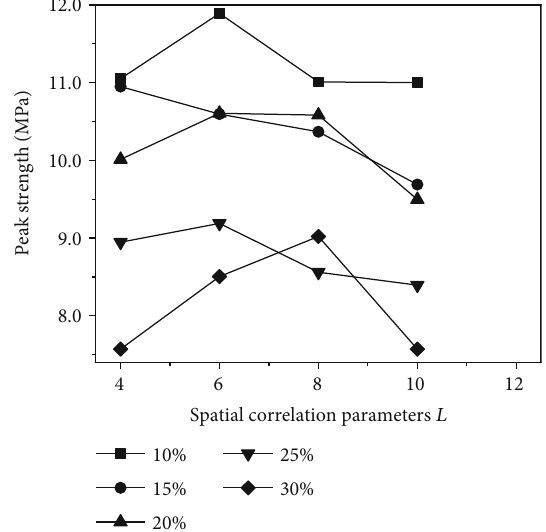
14: The relationship between the peak strength and the change of L